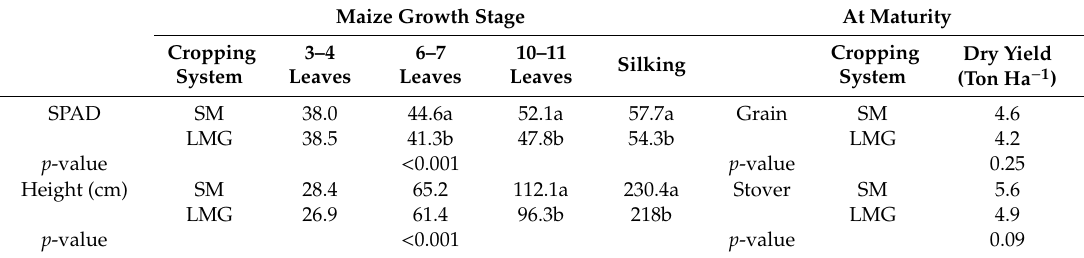
Table 2. Dry yield, height, and SPAD readings of maize in the longan–maize–forage grass system (LMG) and the sole-crop system (SM) in year 7 of the (LMG) and the sole-crop system (SM) in year 7 of the experiment.